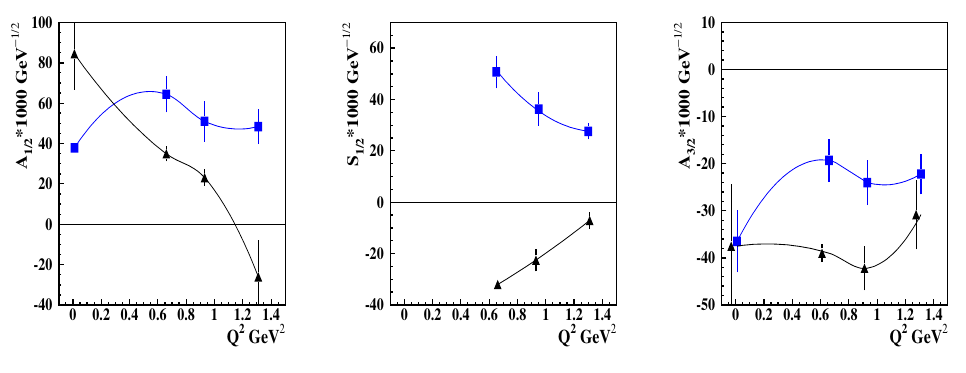
Figure 6. (Color online) Photo- / electrocouplings of the conventional N (1720)3 / 2 + (filled triangles) and candidate N (cid:48) (1720)3 / 2 + (filled squares) states determined from the CLAS data on π + π − p photo- and electroproduction [17, 23] within the JM model.